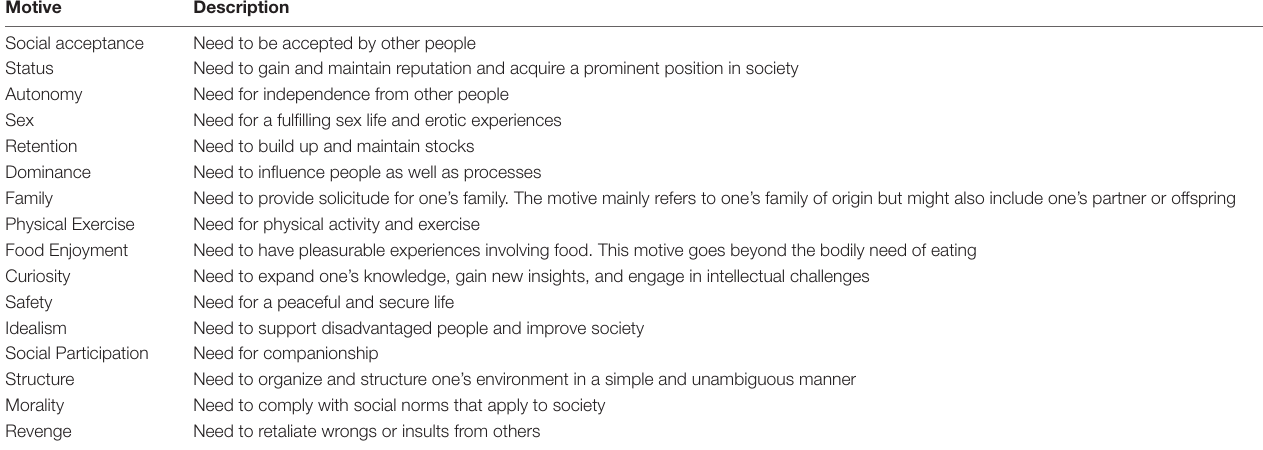
TABLE 1 | Descriptions of the Fundamental Motives assessed by the